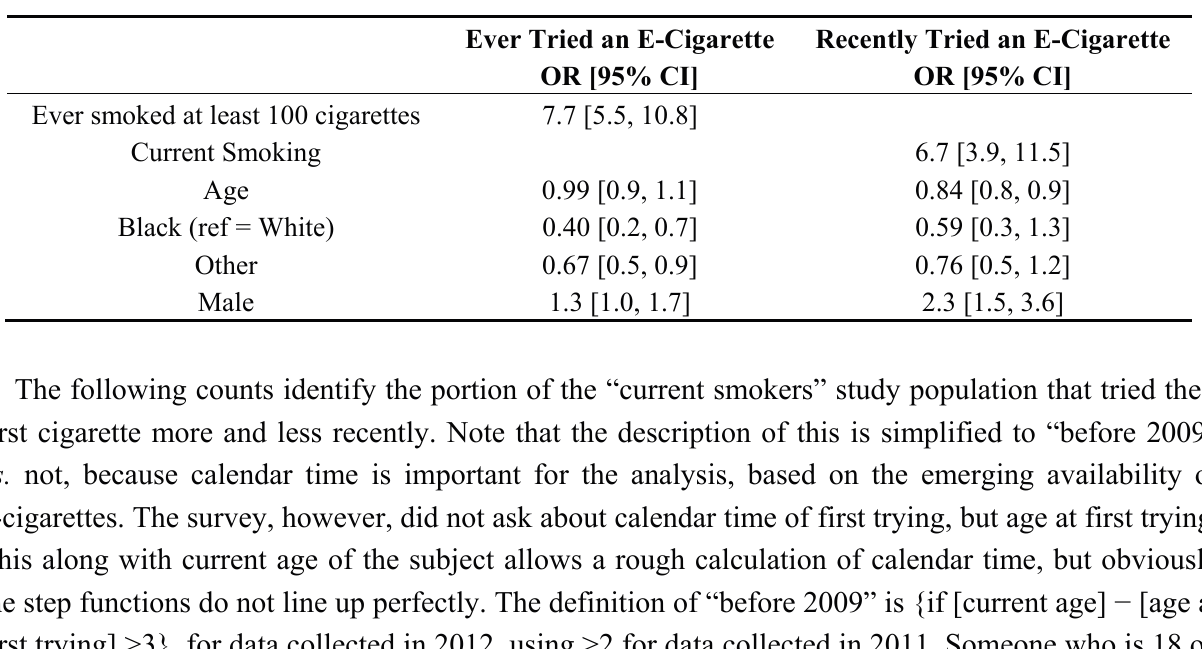
Table 2. Association from Table 1, with dependent and main independent variables reversed.